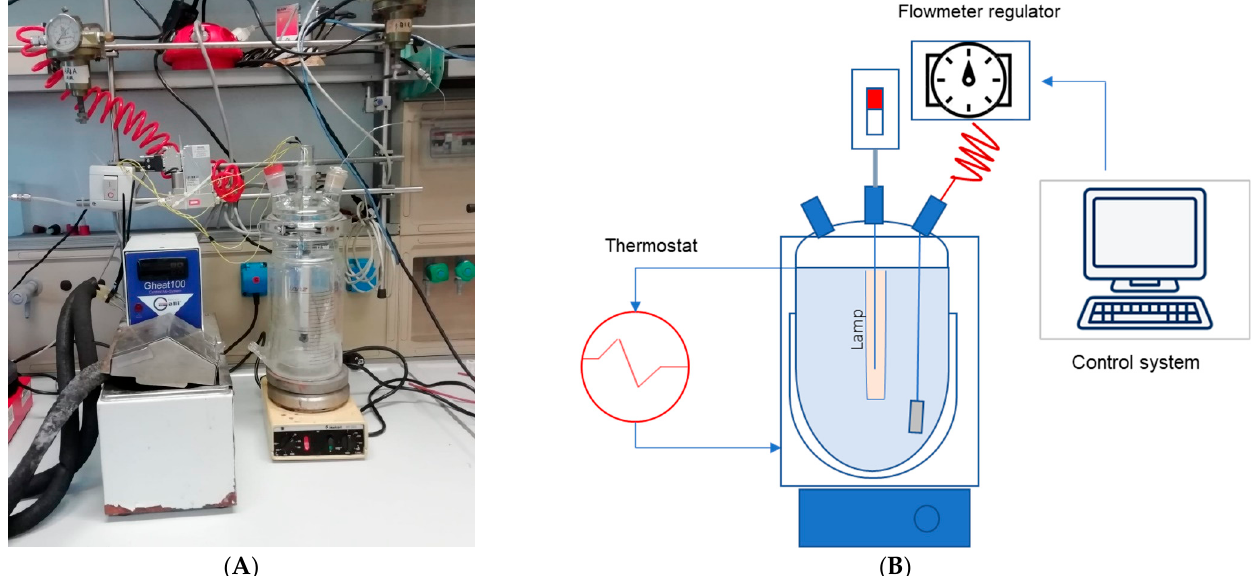
Figure A1. Picture ( A ) and sketch ( B ) of the photoreactor used for the kinetic tests.